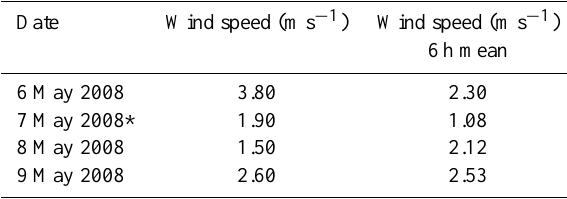
Table 1. Wind speed in May 2008 during sea-surface microlayer sampling as well as mean values for a 6-h period prior to sampling. Samples were taken in the southern Baltic Sea offshore